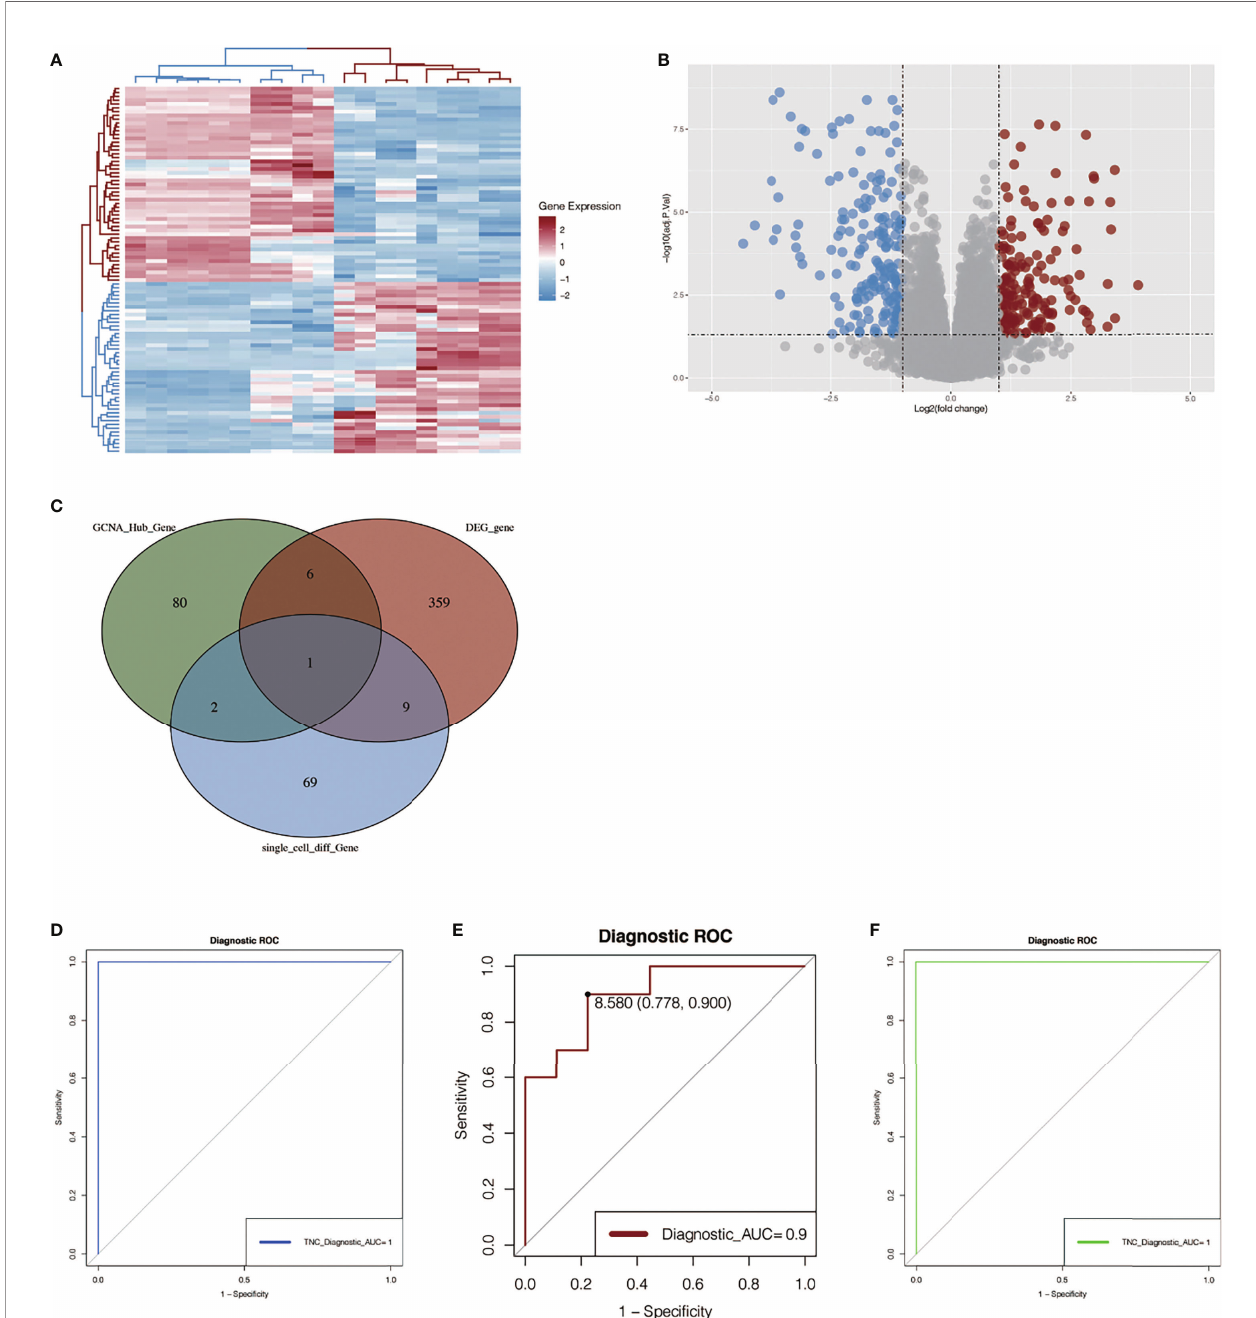
FIGURE 6 | Differential gene analysis in GSE145275 and venn map intersection to obtain the key gene: TNC. (A) Heat maps of difference analysis results. The darker the red, the higher the expression level, and the darker the blue, the lower the expression level. (B) Volcanic maps of differential genes. Blue represents genes that are low-expressed in keloidtissue and red represents genes that arehigh-expressedin keloidtissue. (C) The intersection of single cellanalysis, WGCNA and differential expression analysis was displayedin Venn diagram. The most signi fi cant gene, TNC, was obtained. (D,E) ROC curve construction in publicdata sets to evaluate the diagnosticaccuracy of TNC of keloid. The AUCofdataset GSE145725 was 1.0 (D) . The AUC of ROC curve of dataset GSE44270 was 0.9 (E) . (F) RNA-sequencing dataof ourcenter were usedto construct ROC curve to verify the accuracy ofTNC. The AUCofthe area under the curve